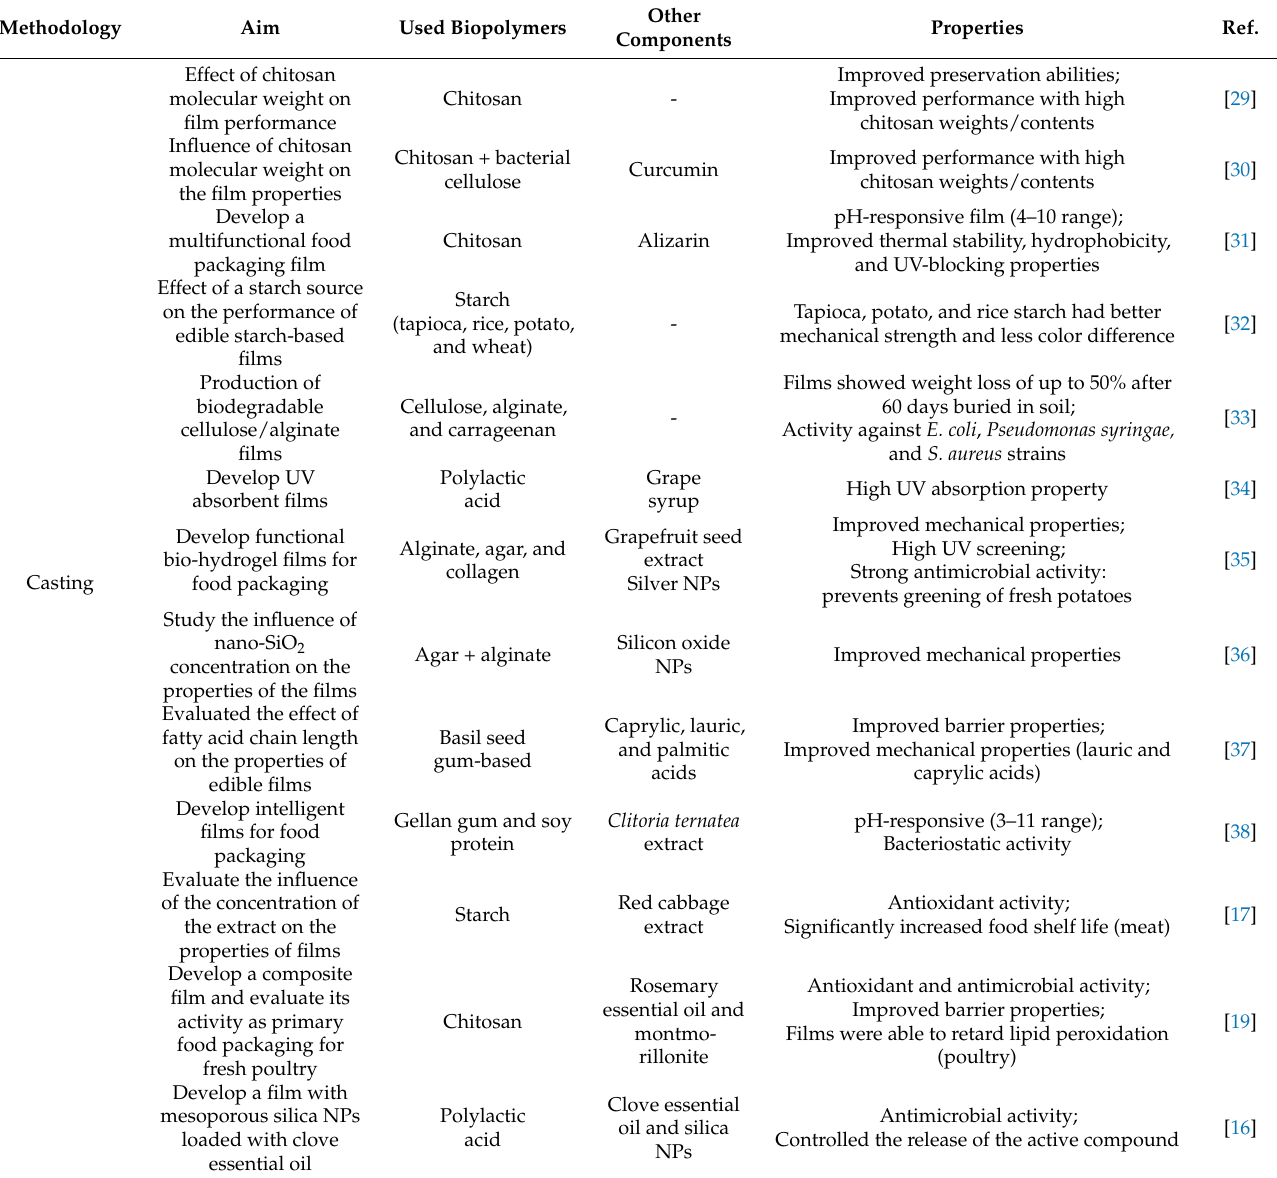
Table 2. Advances in the development of bio-based food packaging